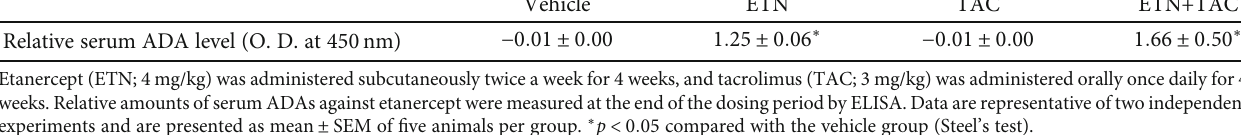
Table 2: Etanercept induces ADA production in hTNF-Tg mice. Vehicle ETN TAC